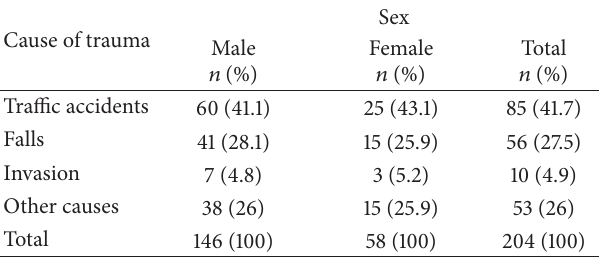
Table 3: The frequency of trauma patients by sex and cause of